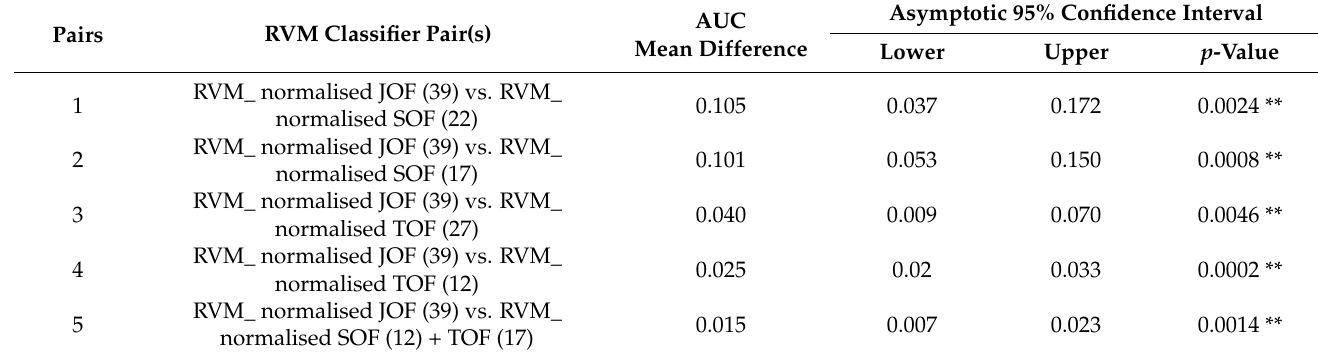
Table 2. Pair-wise corrected resampled t-test of area under the curve (AUC) of RVMs on the training/testing data. Pairs RVM Classifier Pair(s)